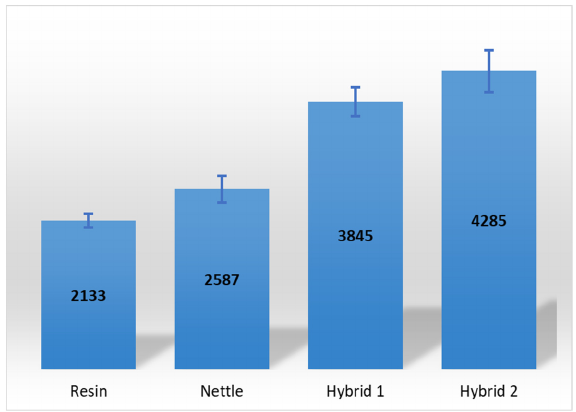
Figure 5. Tensile modulus in MPa. Table 2. Tensile modulus for all samples. Table 2. Tensile modulus for all samples.